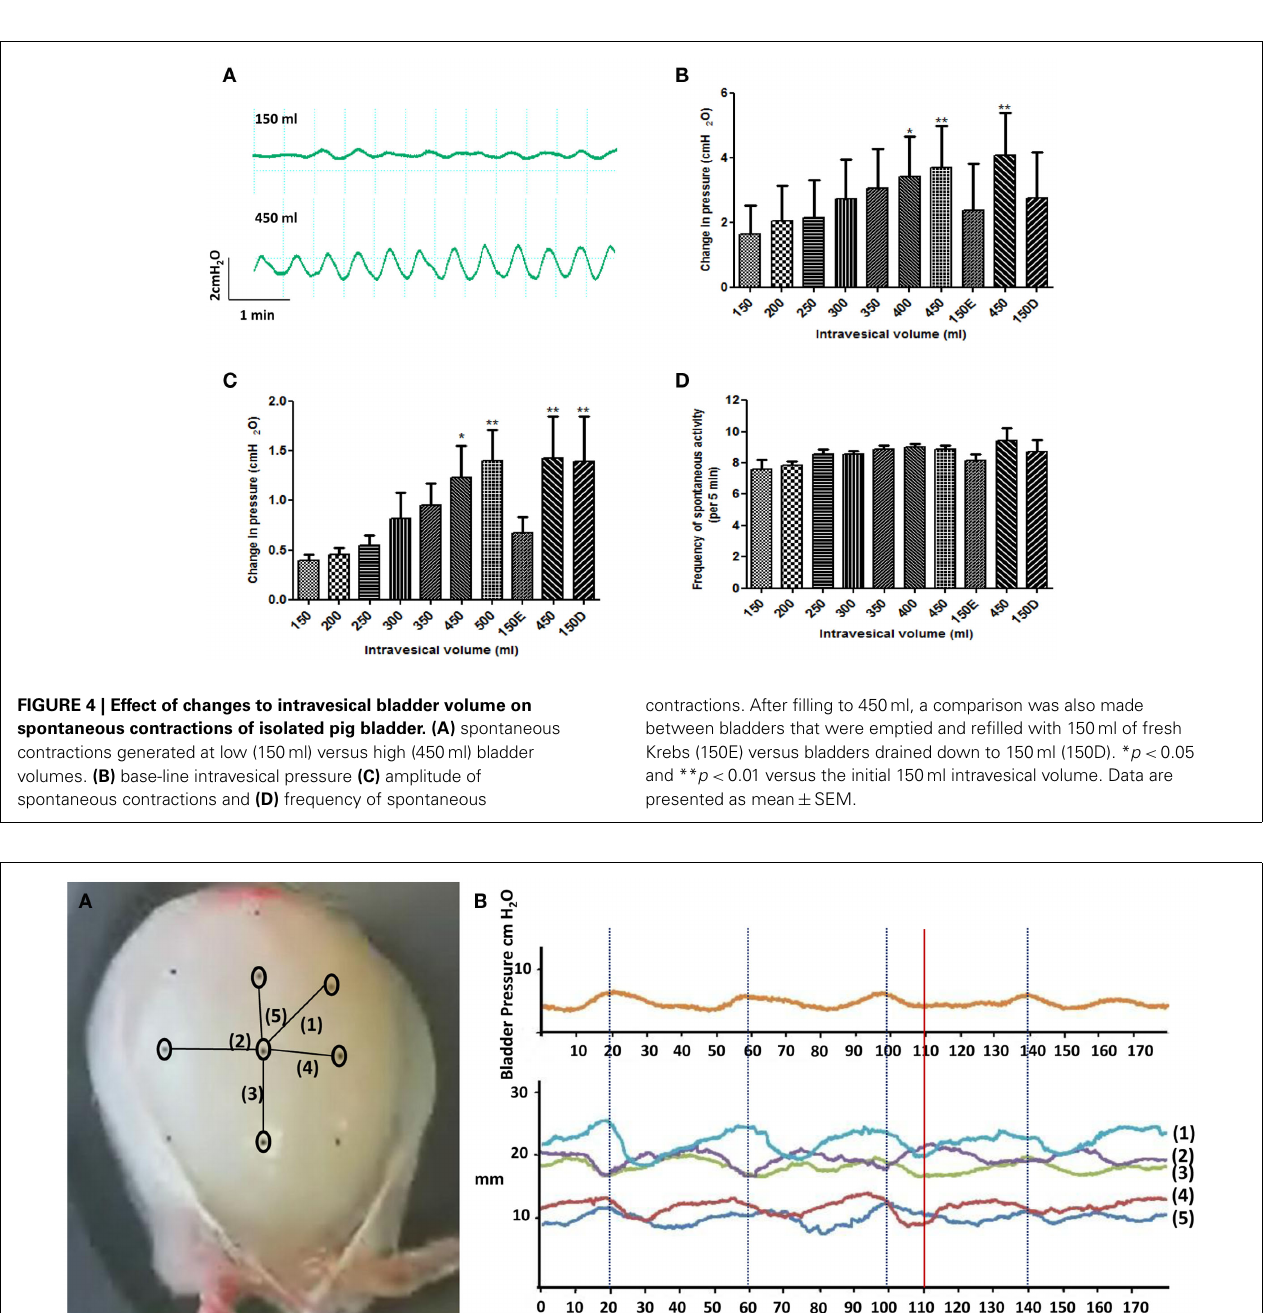
FIGURE 5 |Assessment of bladder wall movements using carbon particles applied to the serosal surface of the bladder as optical markers: (A) demonstrates a photograph of a bladder showing the position of six particles and five consequent axes labeled (1) to (5) and their correlation